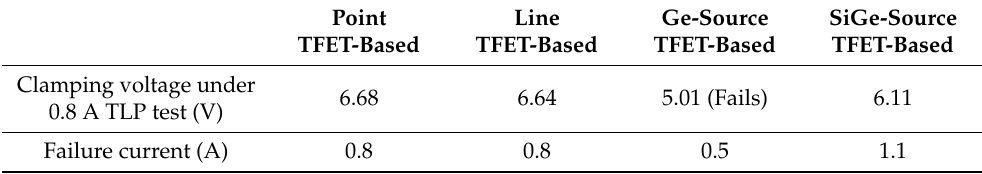
Figure 11. Node voltage and device current under 1.2 A TLP simulation. Table 1. Comparison between four protection networks.